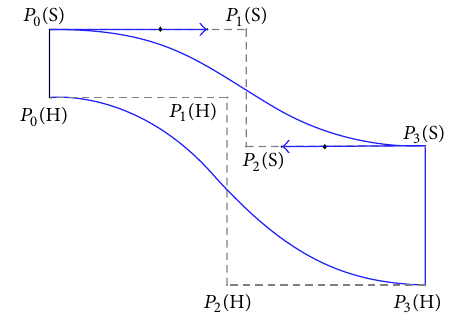
Figure 4: Control points of Bezier